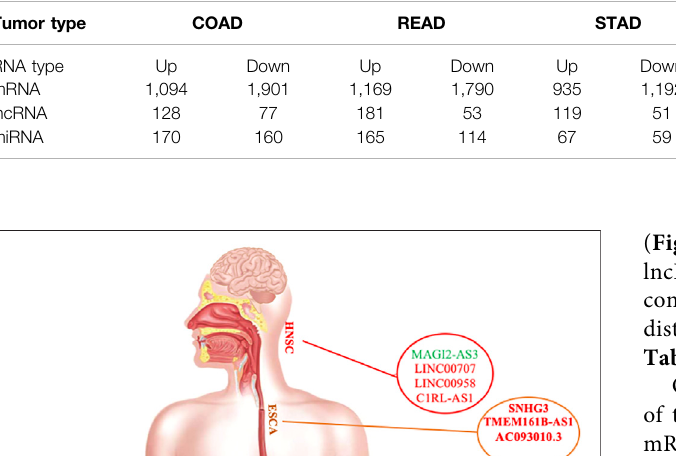
TABLE 1 | Number of differentially expressed mRNAs, lncRNAs, and miRNAs in GI cancers.